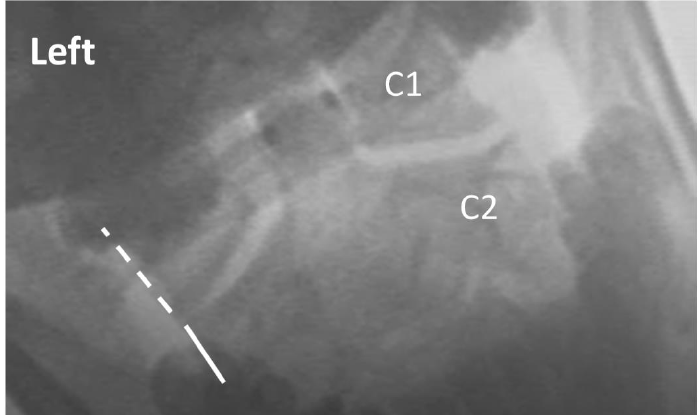
Figure 1. Exemplar of AP open mouth left lateral flexion view of C1 on C2, demonstrating normal alignment. The dashed line indicates the lateral border of the left lateral mass of C1, and the solid line indicates the lateral border of the left articular pillar of C2. The 2 lines are aligned, indicating no translation of C1 on C2 with maximal voluntary left lateral flexion. Note: the image has been reversed so that left on the image corresponds with the patient’s left.